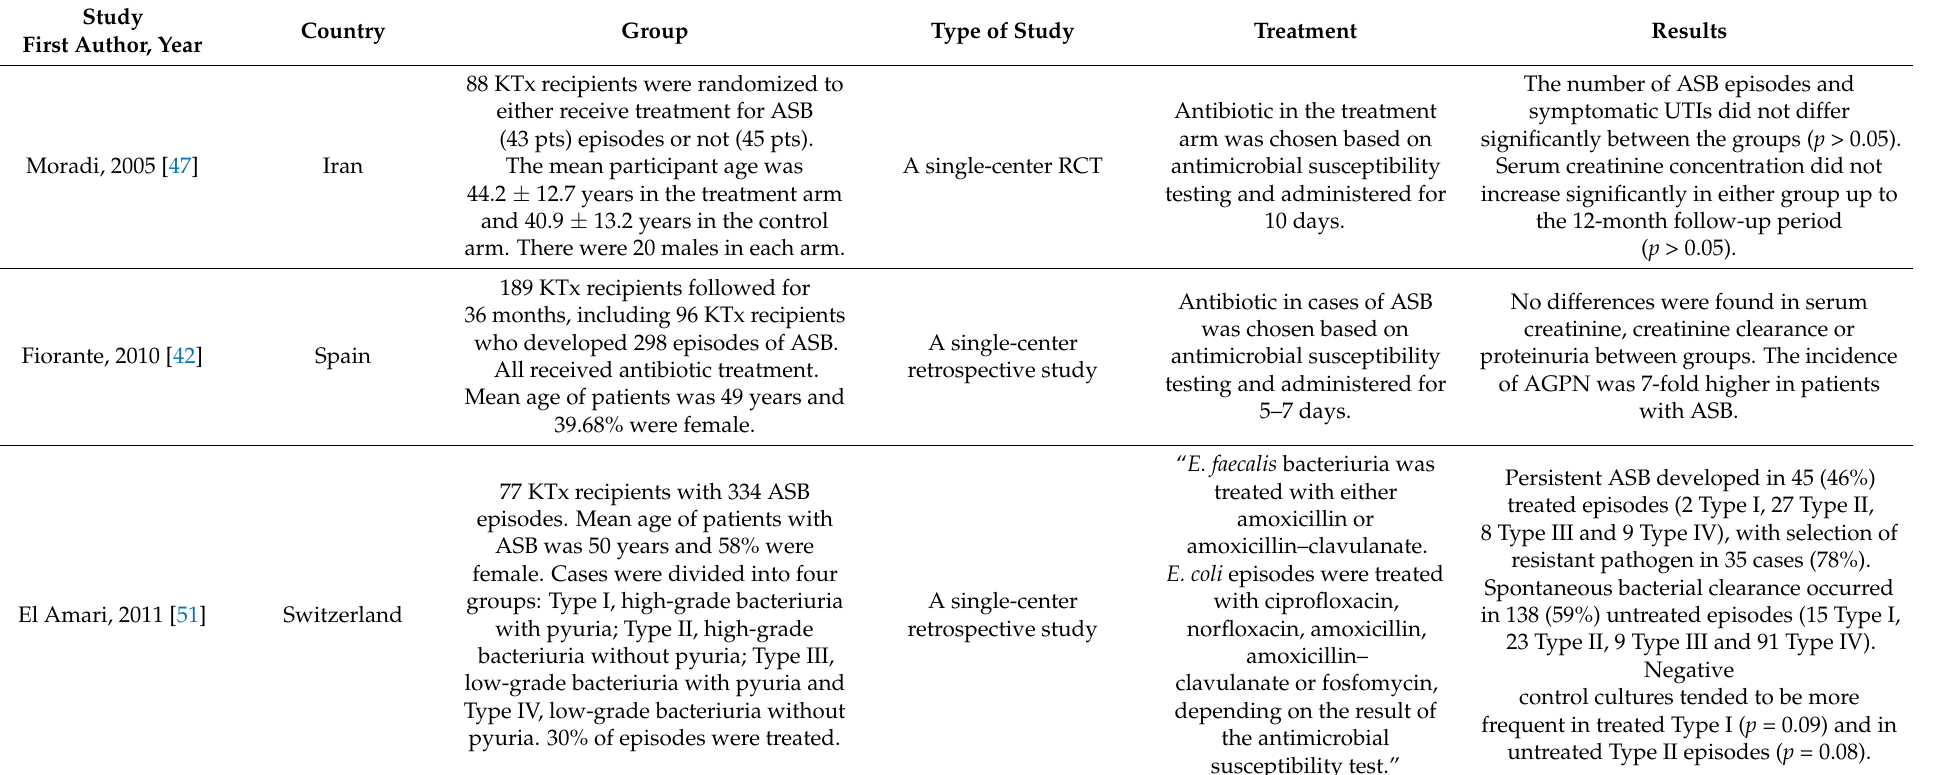
Table 1. Studies that assessed the prevalence, outcomes and management of asymptomatic bacteriuria (ASB) in KTx